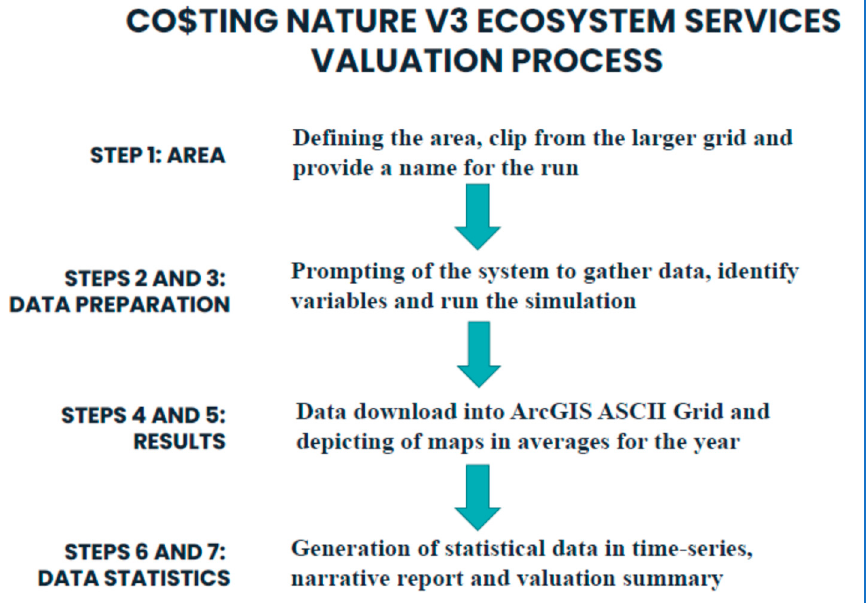
Figure 1. Co$ting Nature V3 valuation process flow.